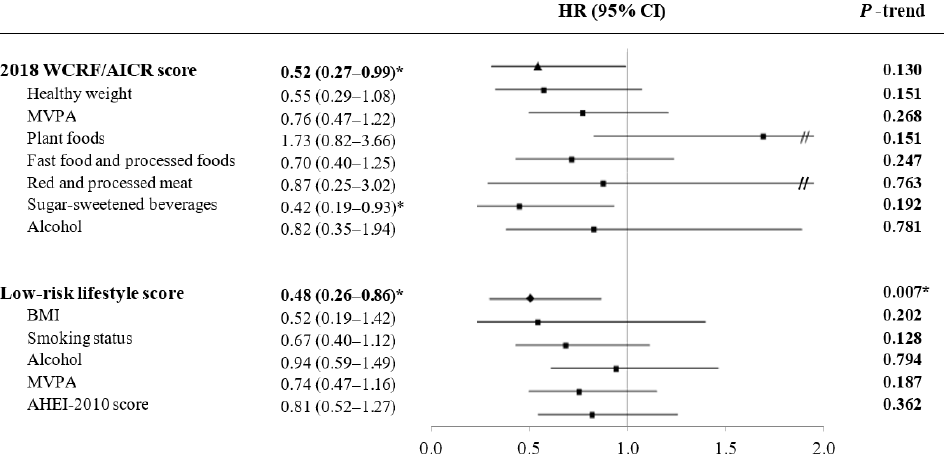
Table 3. Mutually adjusted HRs and 95% CIs for colorectal cancer risk associated with categories of individual components of the 2018 WCRF/AICR score at baseline in the PREDIMED study ( n = 7216).